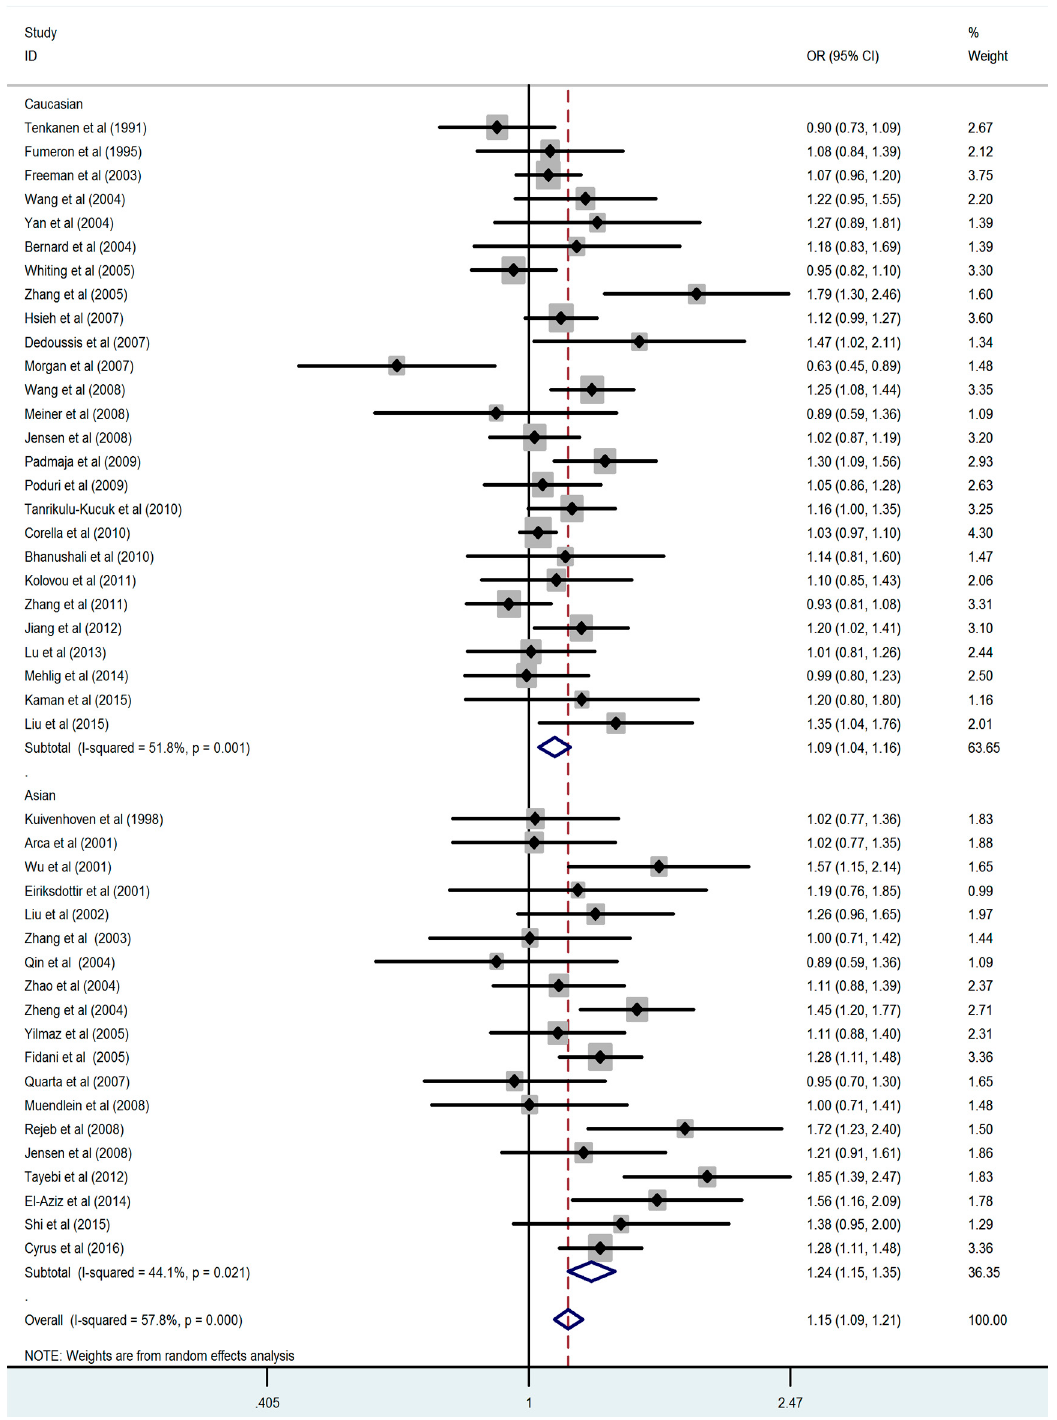
Figure 2. Meta-analysis of atherosclerosis and the CETP TaqIB polymorphism ( B1 vs. B2 ).